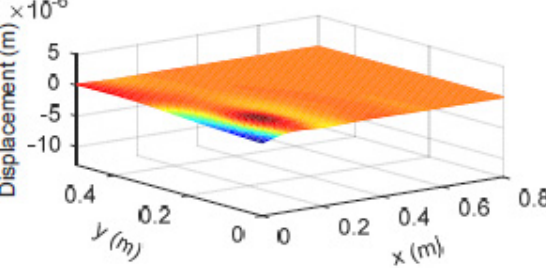
Figure 14. The displacement profile of the locally resonant plates with damped resonators with fully free boundary conditions at 304